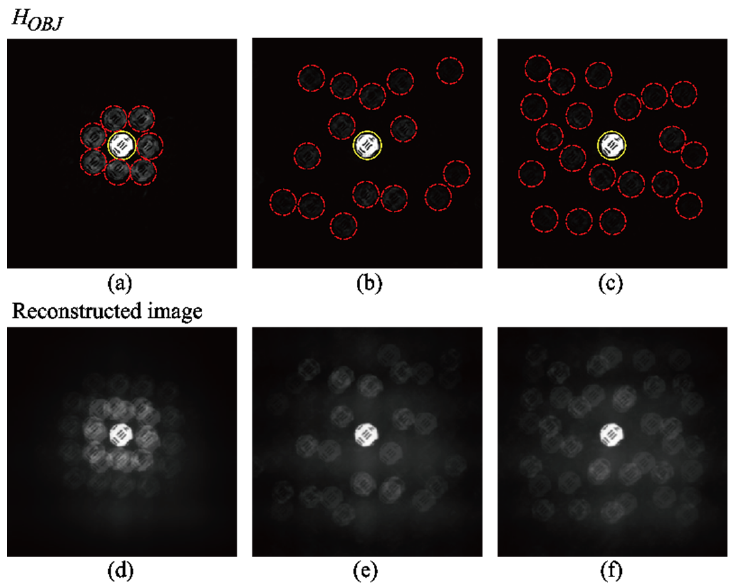
Figure 6. Optical configuration.